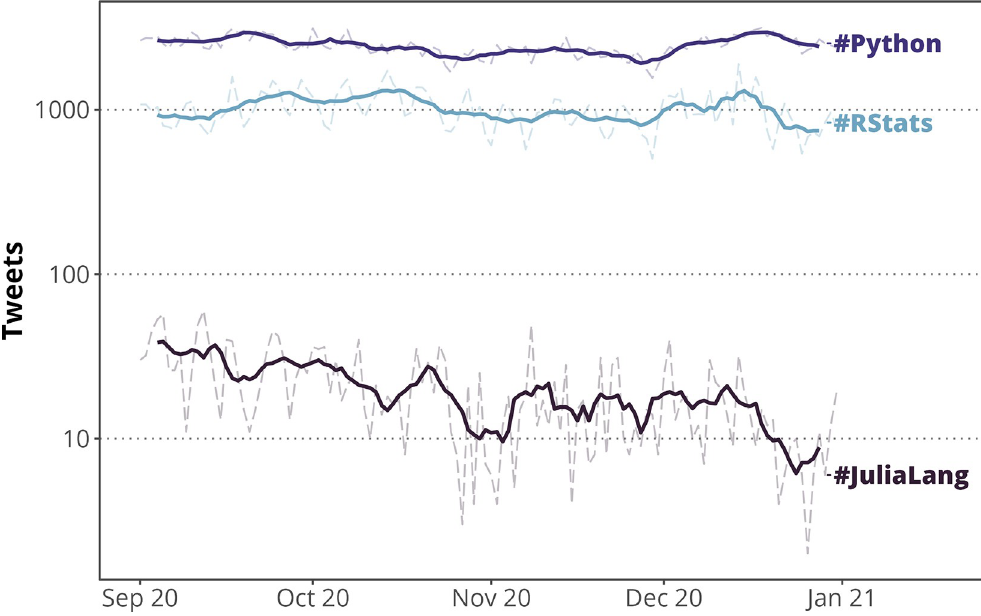
Fig 2. Popularity of Twitter discussion for some common scientific programming languages. While not as popular as #Python, #RStats appeared in around 1,000 tweets per day on average at the end of 2020. Solid lines show 7-day rolling averages; transparent dashed lines show daily tweet counts. Tweets were collected from September 1, 2020 to December 31, 2020, using the R package, academictwitteR [24]. We found a total of 124,852 Tweets with the #rstats hashtag, 303,388 with the #python hashtag, and 2,522 with the #julialang hashtag, within this 4-month period.